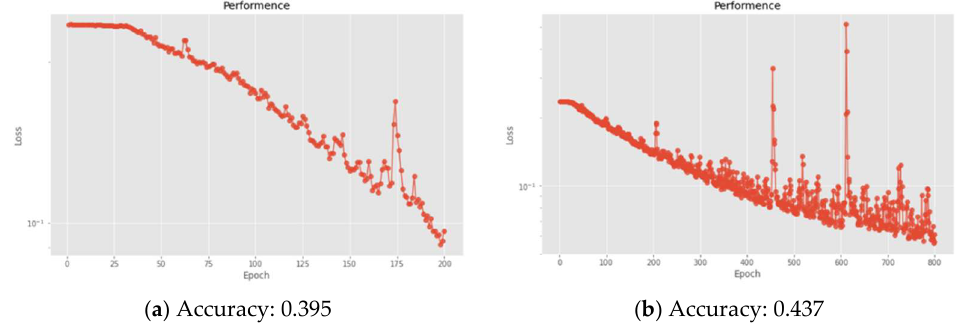
Figure 13. Loss function and accuracy of various epoch settings of DNN. ( a ) Epoch = 200, underfitting. ( b ) Epoch = 800, overfitting.